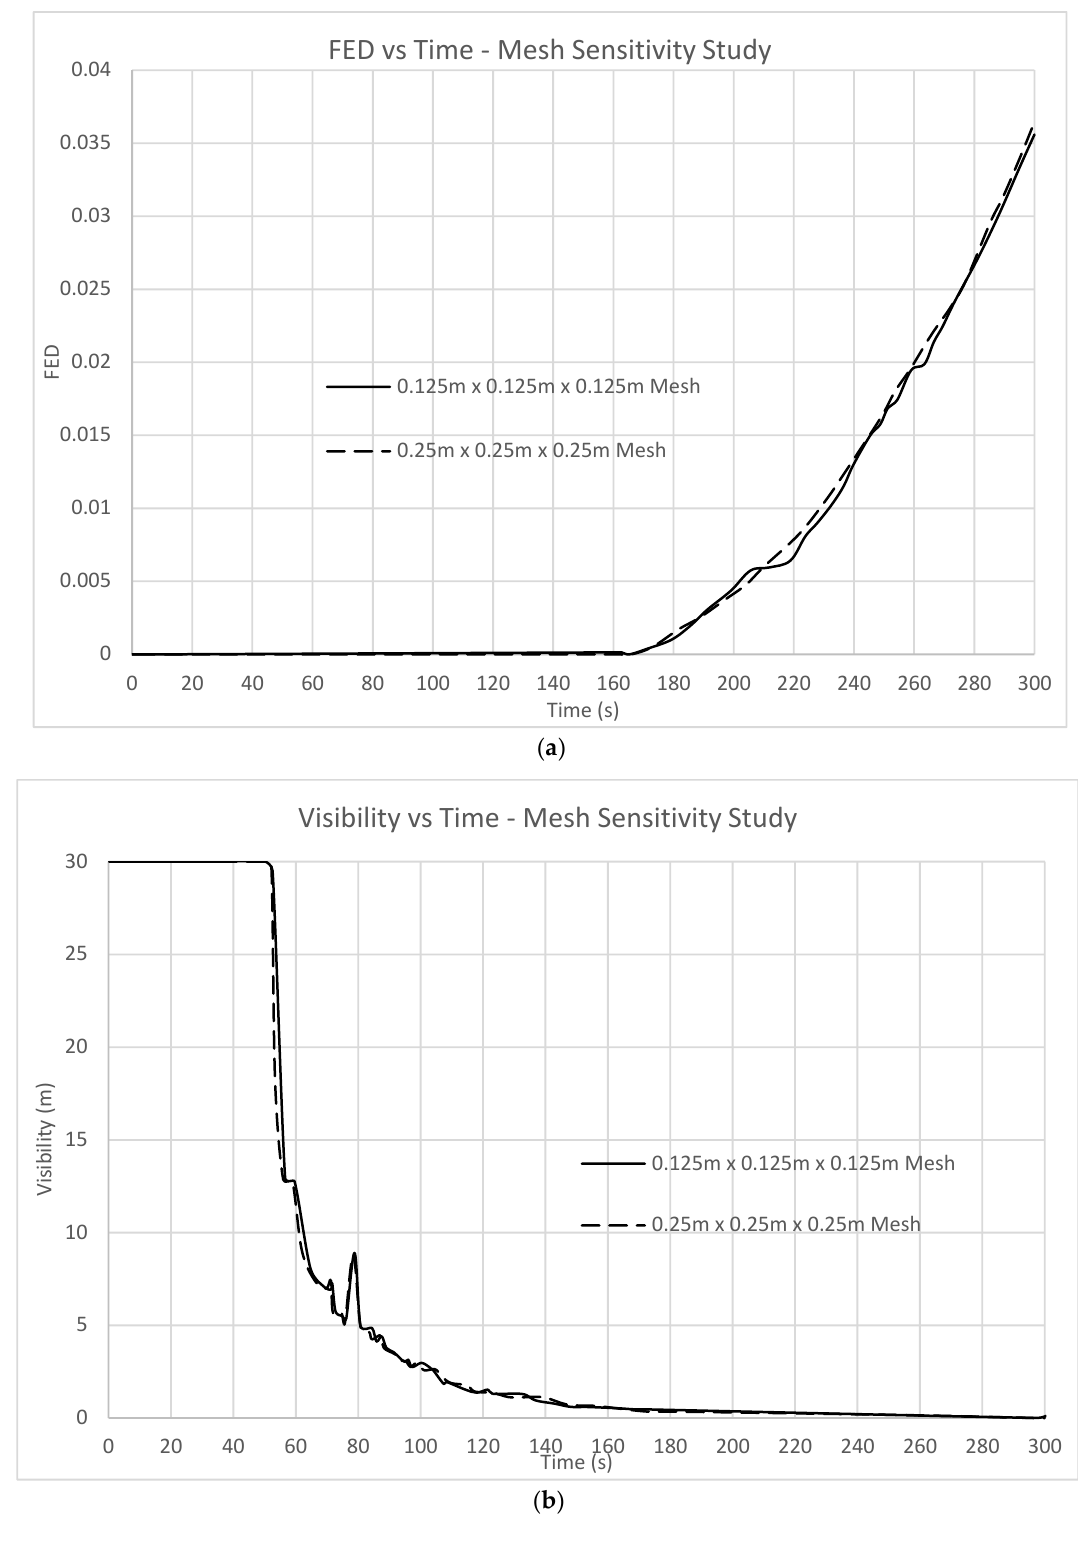
Figure 4. Comparison of mesh sensitivity study: ( a ) FED vs. Time, ( b ) Visibility vs Time